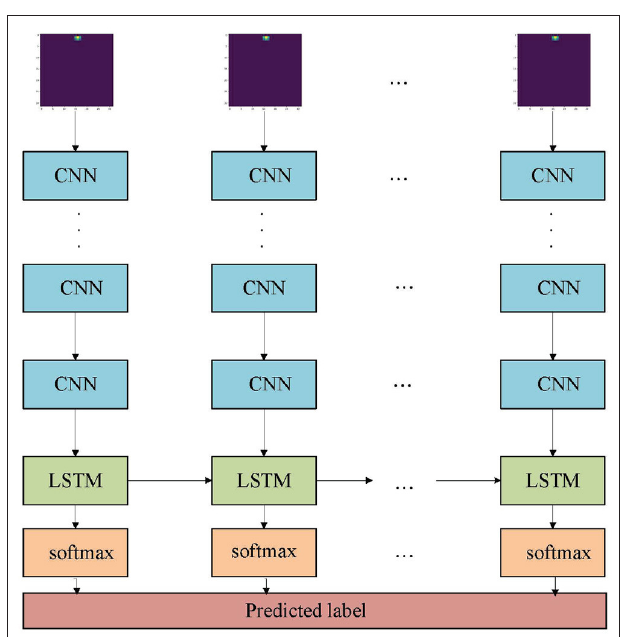
FIGURE 2 | A diagram of the model architecture. The CNNs form a ResNet-18 model (He et al., 2016). The Long short-term memory (LSTM) is an RNN model with two hidden layers, each with 512